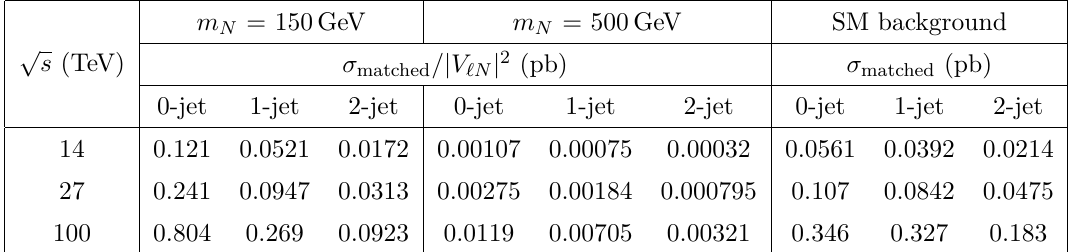
Table 4 . Exclusive cross sections of trilepton signal process in eq. (2.4) with m N = 150 GeV or √ 500 GeV and the dominant SM background in eq. (3.2) at s = 14 TeV, 27 TeV and 100 TeV, with 0, 1 or 2 jets. We have taken ‘ = µ and adopted the acceptance cuts in table 1. Note that the cross sections for the SM backgrounds with 0 and 1 jet at 14 TeV are different from those in table 3, as the cuts are